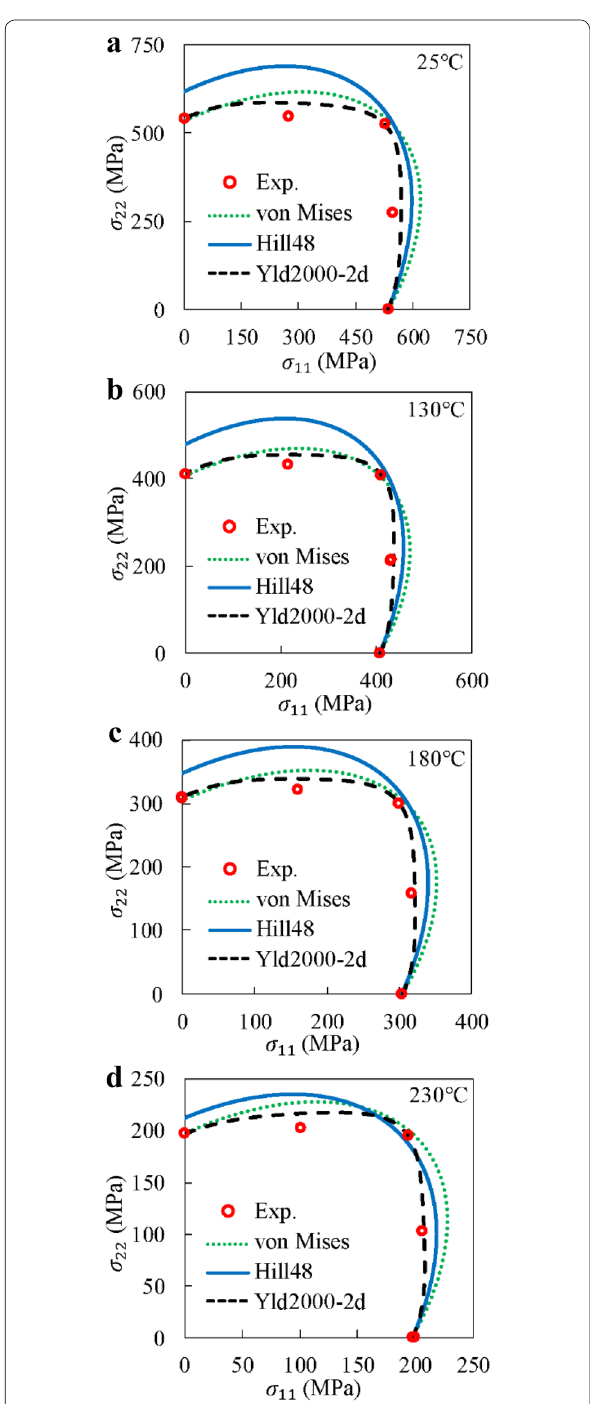
Figure 13 Comparision of yield loci from experiments and calcalated by yield functions wih ε p = 0.002 at ( a ) 25 °C, ( b ) 130 °C, ( c ) 180 °C and ( d ) 230 °C